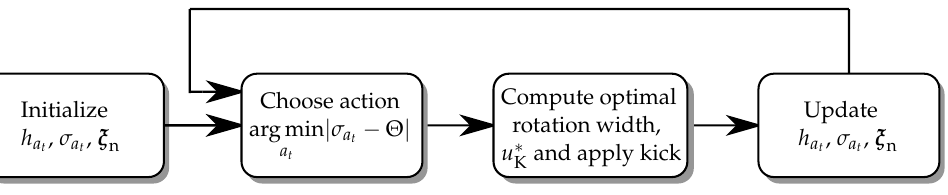
Figure 12. Outline of the control algorithm combining adaptive direction parameters and neural networks for the rotation width